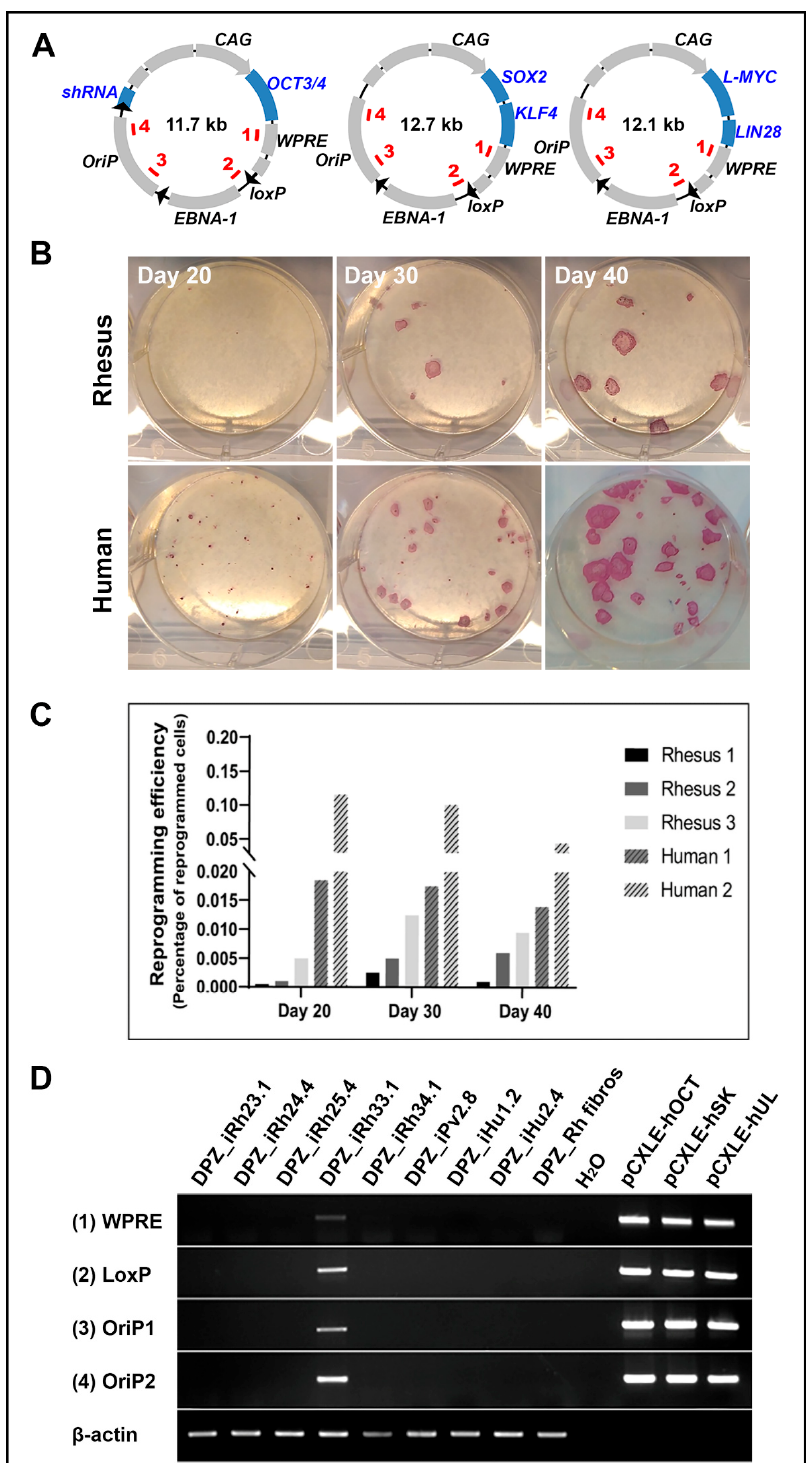
Figure3. Comparisonofreprogrammingefficienciesbetweenrhesusandhumanfibroblastsusingepisomal plasmids. ( A ) Reprogramming vectors used in this study (modified after [40]). Primer-binding sites (1–4) for plasmid detection are depicted within the plasmid DNA. ( B ) To compare reprogramming efficiencies, skin fibroblasts from three different rhesus macaques and two human donors were nucleofected